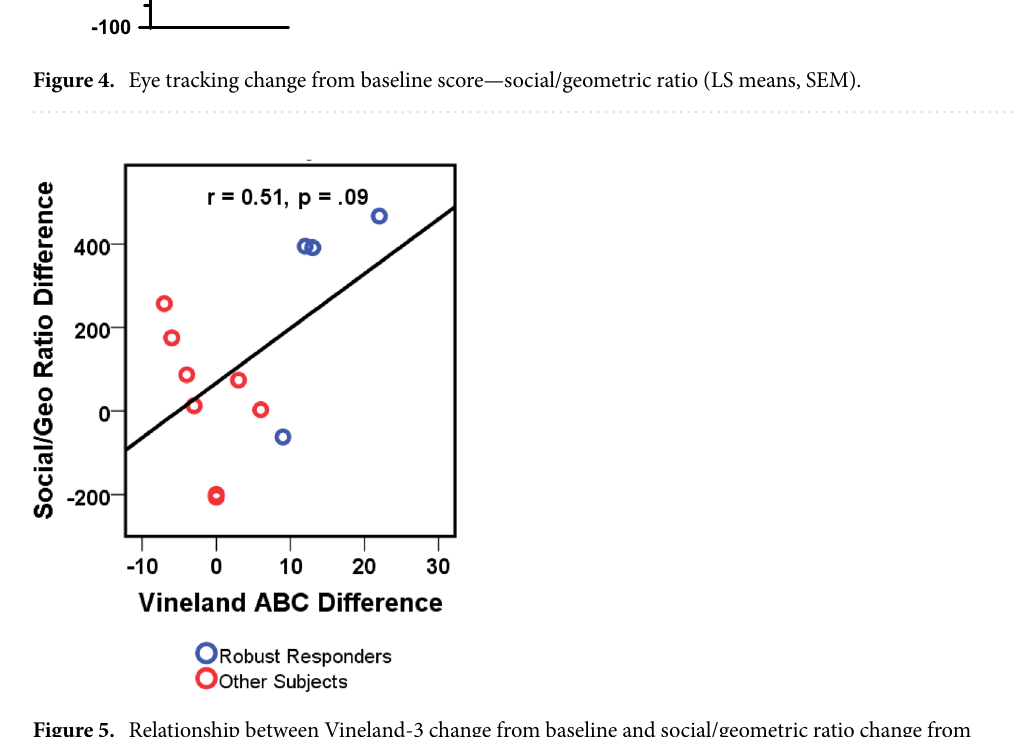
Figure 5. Relationship between Vineland-3 change from baseline and social/geometric ratio change from baseline following SB-121.